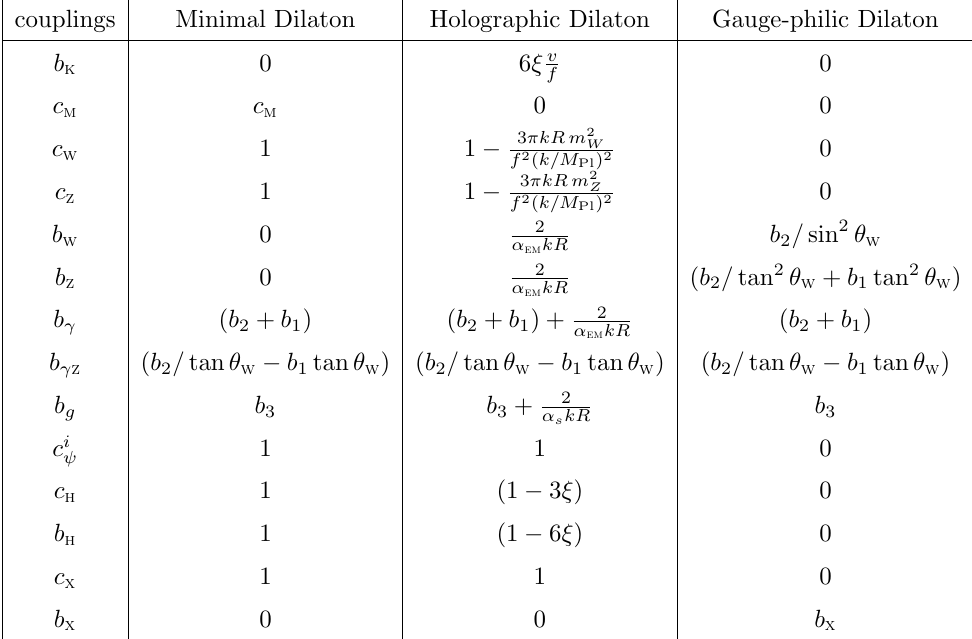
Table 1 . The model dependent couplings b ’s and c ’s of the minimal dilaton, holographic dila- ton, and gauge-philic dilaton models. Here (cid:24) is the Higgs-curvature mixing parameter and kR is the volume factor in the holographic model. Whereas, (cid:11) and (cid:11) s are the electromagnetic and em strong coupling constants, respectively, and (cid:18) is the Weinberg angle. Above b 3 ; b 2 ; b 1 are w